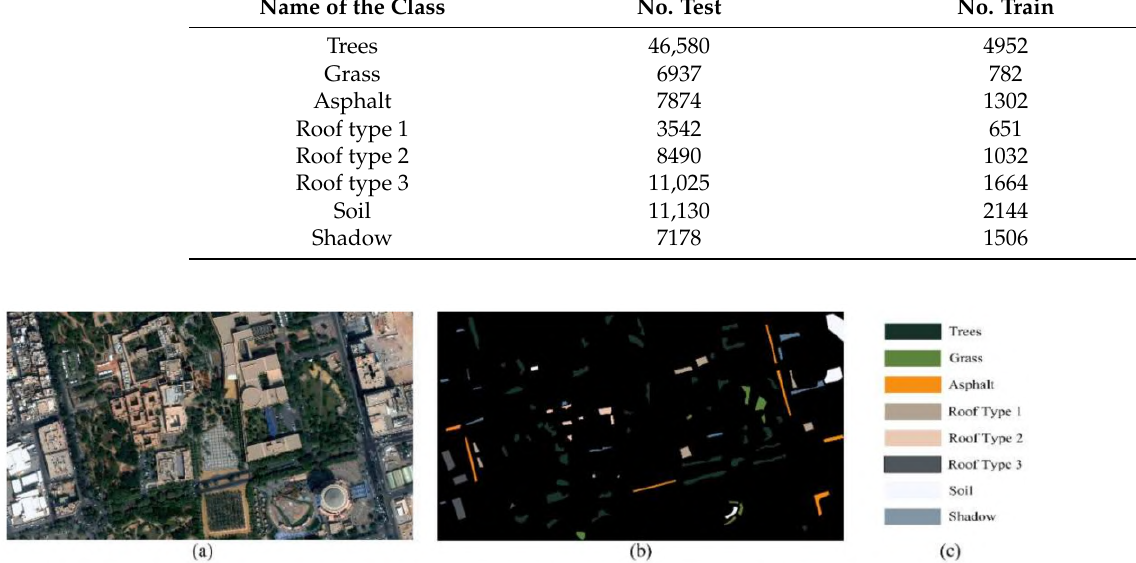
Figure 6. ( a ) World-View 2 subset ( b ) Ground reference and ( c )